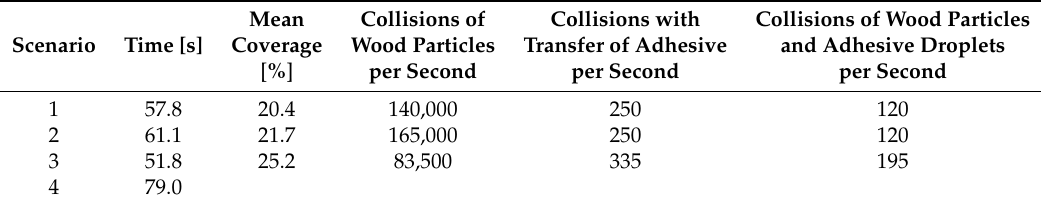
Table 7. Summary of key figures for scenarios